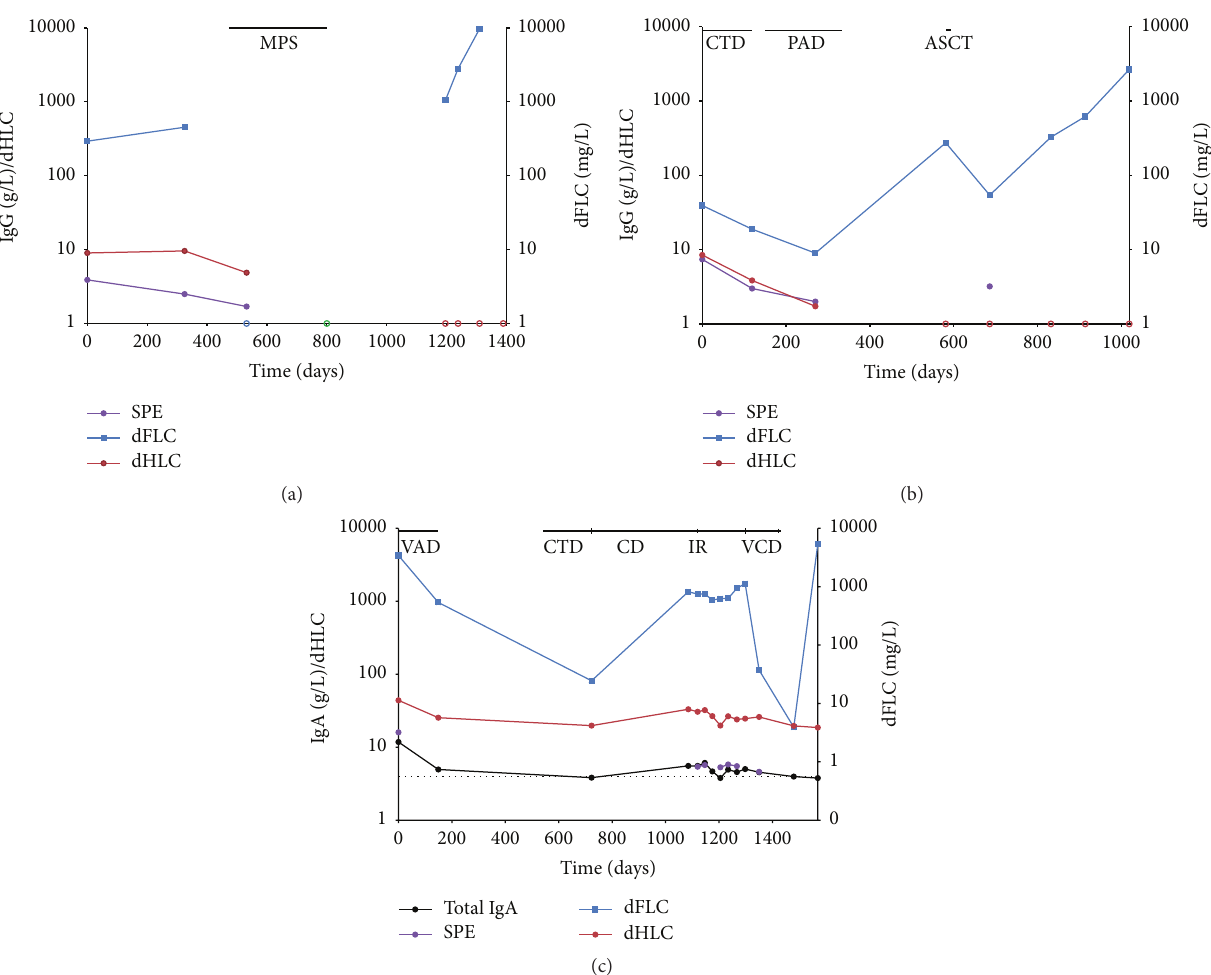
Figure 1: Disease course of patients with (a) biclonal MGUS progressing to LCMM (case 1 ), (b) oligosecretory IgG 𝜅 MM (case 2 ), and (c) IgA 𝜅 IIMM (case 3 ). MGUS: monoclonal gammopathy of undetermined significance, LCMM: light chain multiple myeloma, MM: multiple myeloma, IIMM: intact immunoglobulin multiple myeloma, SPE: serum protein electrophoresis, dFLC: difference in concentration between involved and uninvolved free light chain measurement (Freelite), dHLC: difference in concentration between involved and uninvolved heavy/light chain measurement (Hevylite), MPS: methylprednisolone, CTD: cyclophosphamide, thalidomide, and dexamethasone, PAD: bortezomib, doxorubicin, and dexamethasone, VAD: vincristine, doxorubicin, and dexamethasone, CD: cyclophosphamide and dexamethasone, IR: ionising radiation, VCD: bortezomib, cyclophosphamide, and dexamethasone, and ASCT: autologous stem cell transplant; blue open circle indicates a normalised sFLC ratio, red open circle indicates a normalised HLC ratio, and green open circle indicates normalised sFLC and HLC